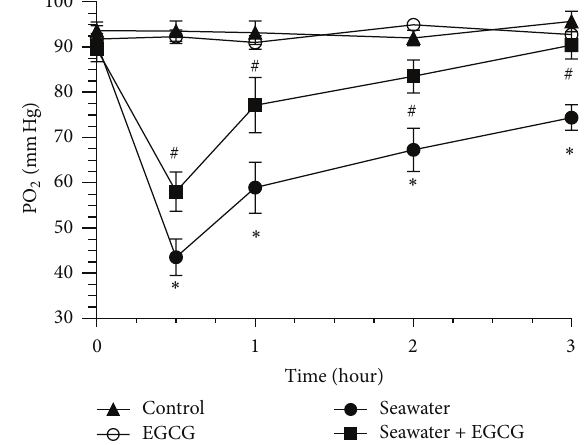
Figure 2: Effect of EGCG on PaO 2 in seawater aspiration-induced ALI. Seawater aspiration-induced ALI caused a significant decrease of PaO 2 in a time dependent manner, which could be partly reversed by EGCG pretreatment. Data were presented as means ± SEM ( 𝑛 = 8 ). ∗ 𝑃 < 0.05 versuscontrolgroup; # 𝑃 < 0.05